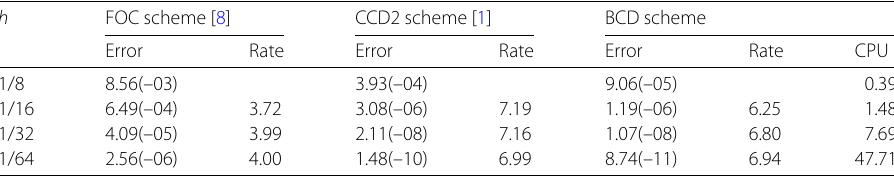
Table 4 The maximum absolute error and convergence rate for Problem 3 with Re = 10 2